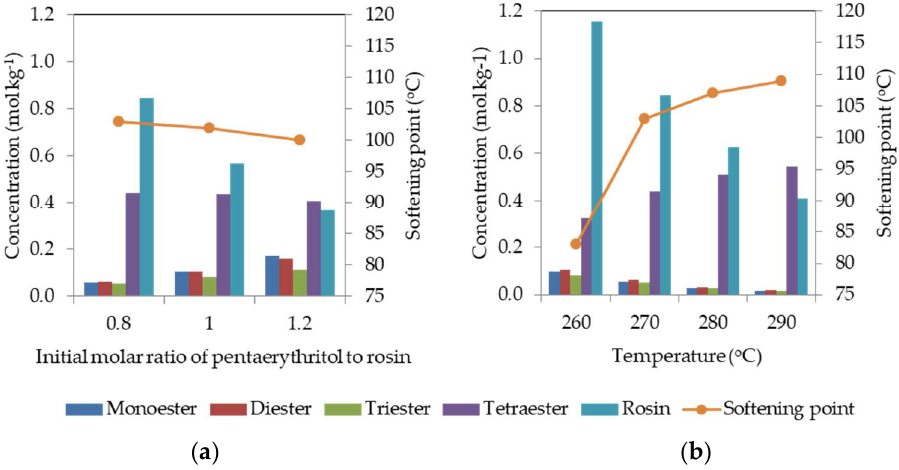
Figure 7. Predicted concentration and experimental softening point ( a ) at 270 °C and several initial molar ratios of pentaerythritol to rosin ( b ) at several temperatures with the initial ratio of 0.8 in 4 h reaction time.